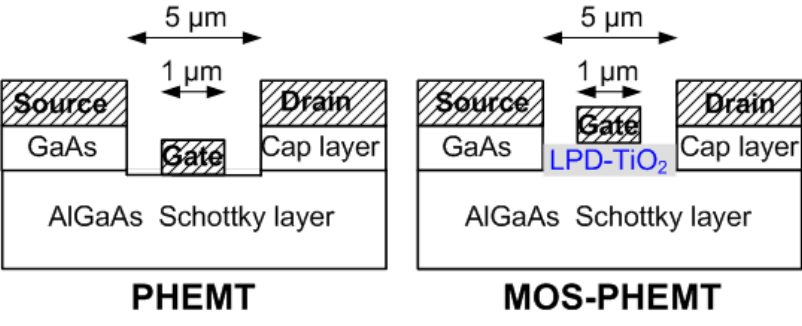
Figure 1. Schematic structures of AlGaAs/InGaAs PHEMT and MOS-PHEMT.